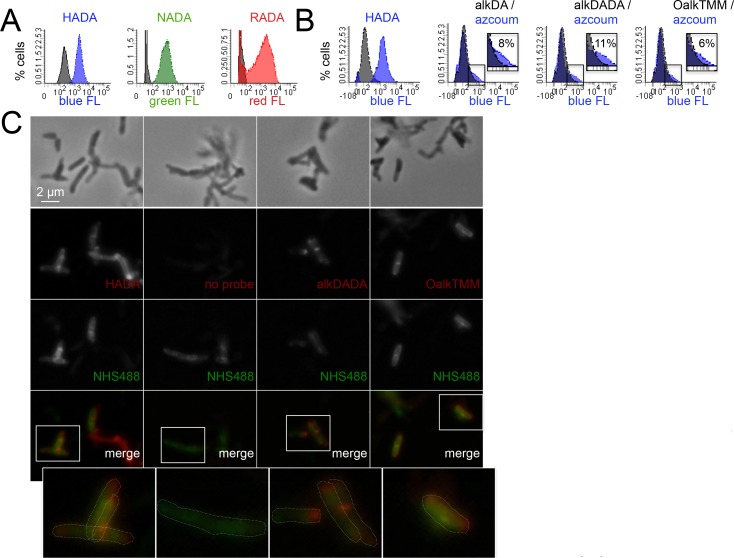
Heterogeneous envelope probe labeling in M. tuberculosis.(A) M. tuberculosis was incubated or not for 20 hr in HADA (blue), NADA (green) or RADA (red), washed and fixed. Fluorescence was assessed by flow cytometry. Grey, unlabeled control. (B) M. tuberculosis was incubated or not for 2 hr with HADA, alkDA, alkDADA or OalkTMM (all blue). After washing and fixing as in A, cells labeled with alkynyl probes were subjected to CuAAC with azido-coumarin. Fluorescence was assessed by flow cytometry. Grey, no probe control. Non-overlapping regions of the histograms that represent bacteria with probe-derived fluorescence are magnified and quantitated as % of total bacteria counted. (C) Fluorescence microscopy of M. tuberculosis briefly treated with a fluorescent amine-reactive dye (NHS488; green) then incubated or not for 2 hr with HADA, alkDADA or OalkTMM (red). Alkynyl probes detected as in B. Cell envelope labeling is apparent both along the sidewall, where it colocalizes with NHS488, as well as at the cell poles, where it does not. Dotted white lines highlight cell contours.10.7554/eLife.37243.007Figure 2—figure supplement 2—source data 1.Flow cytometry and conventional fluorescence microscopy images of M. tuberculosis labeled with different probes.